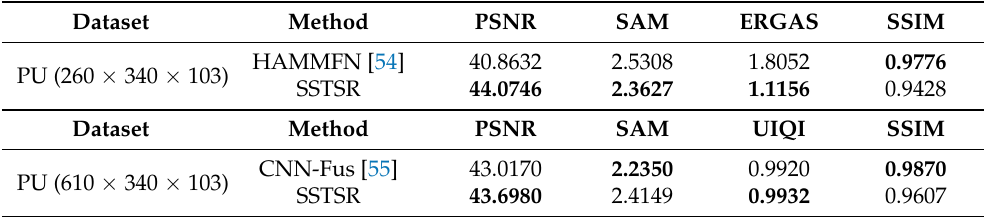
Table 2. Comparison of quantitative indicators between the proposed method and the deep learn- ing